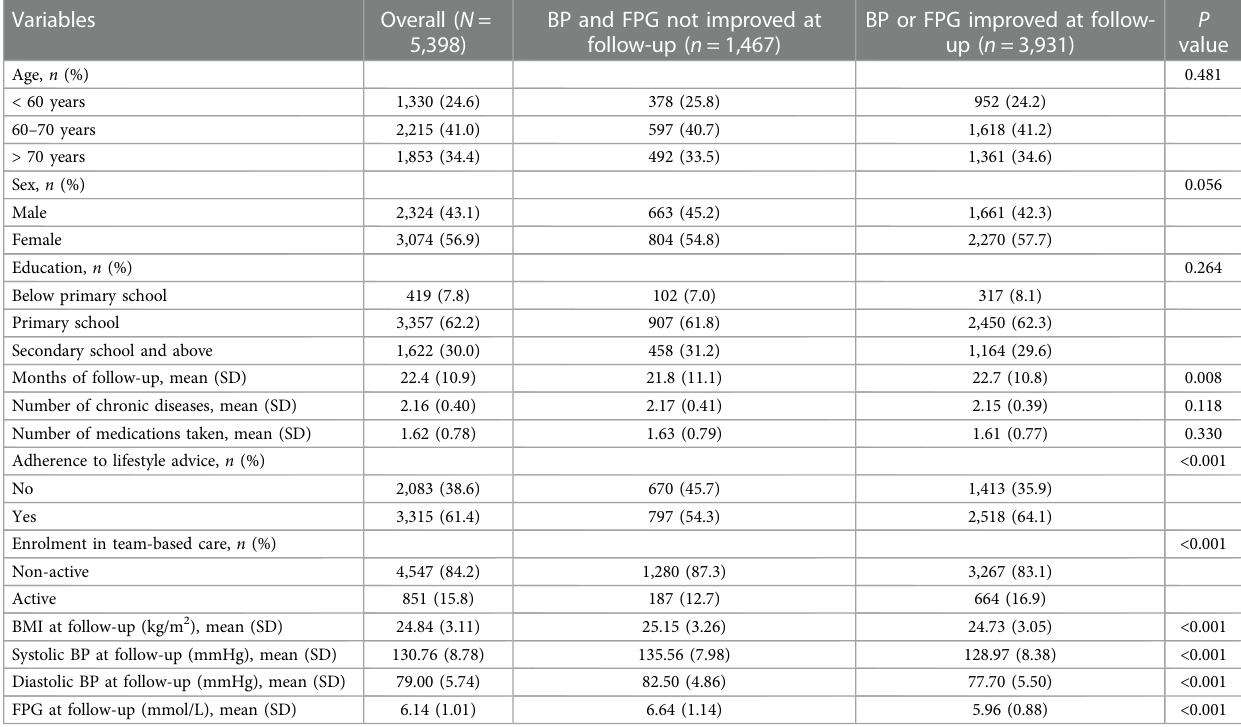
TABLE 2 Characteristics of study participants according to the improvement of blood pressure and fasting plasma glucose at follow-up.